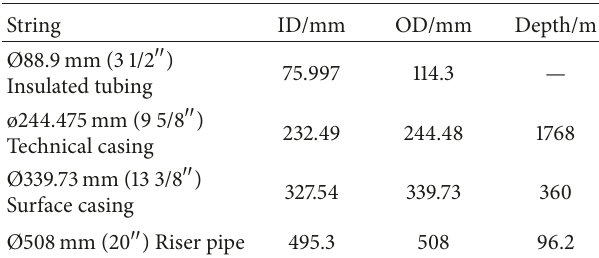
Table 1: Wellbore structure